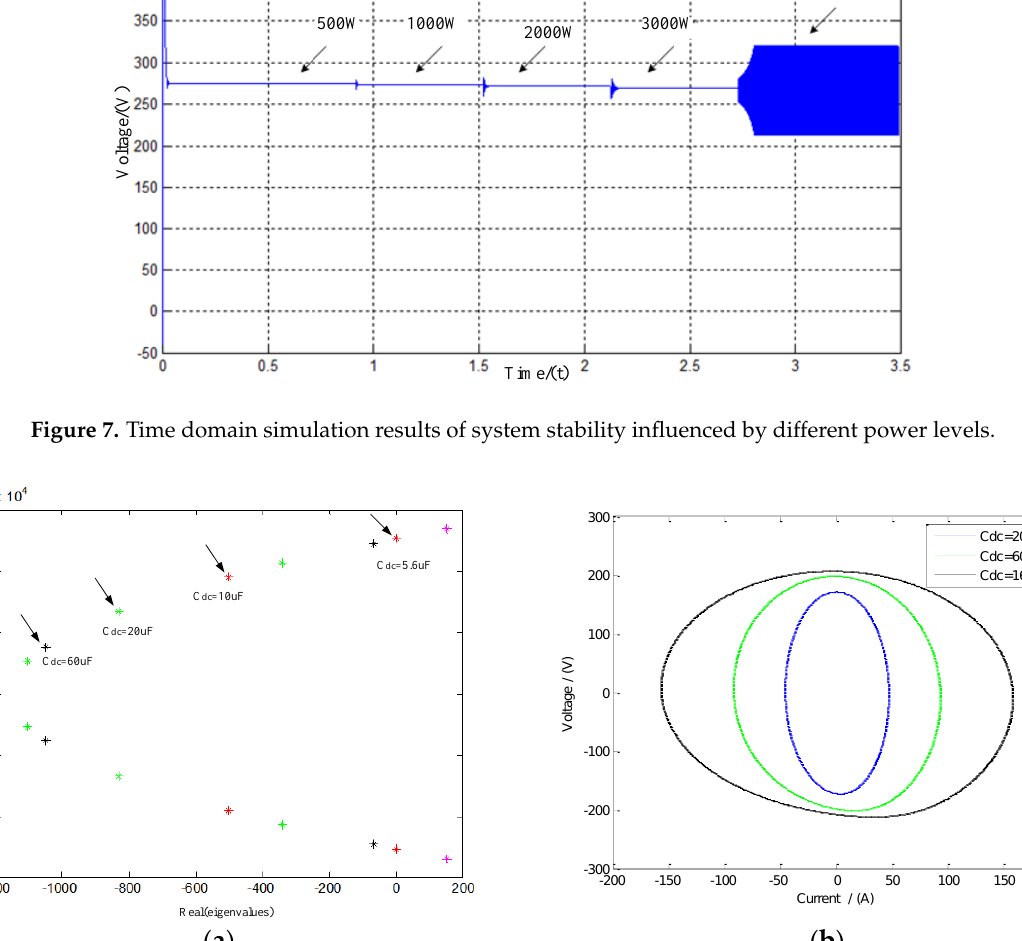
stability; ( b ) large signal stability. ( b ) large signal stability.